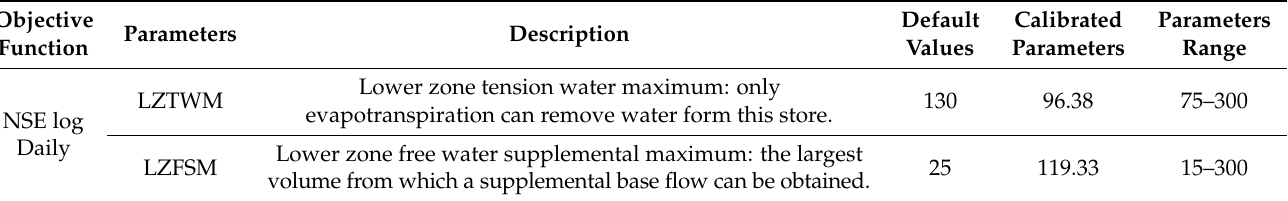
Table 6. Calibrated parameters of the Sacramento rainfall–runoff